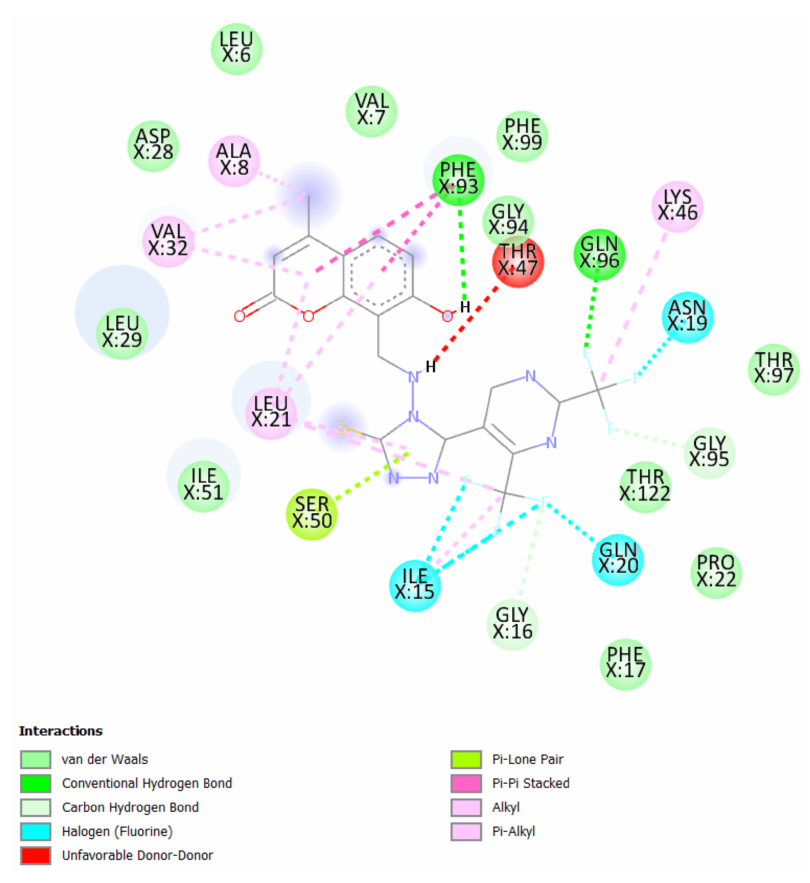
Figure 6. Docking interactions of designed compound h with DHFR enzyme.